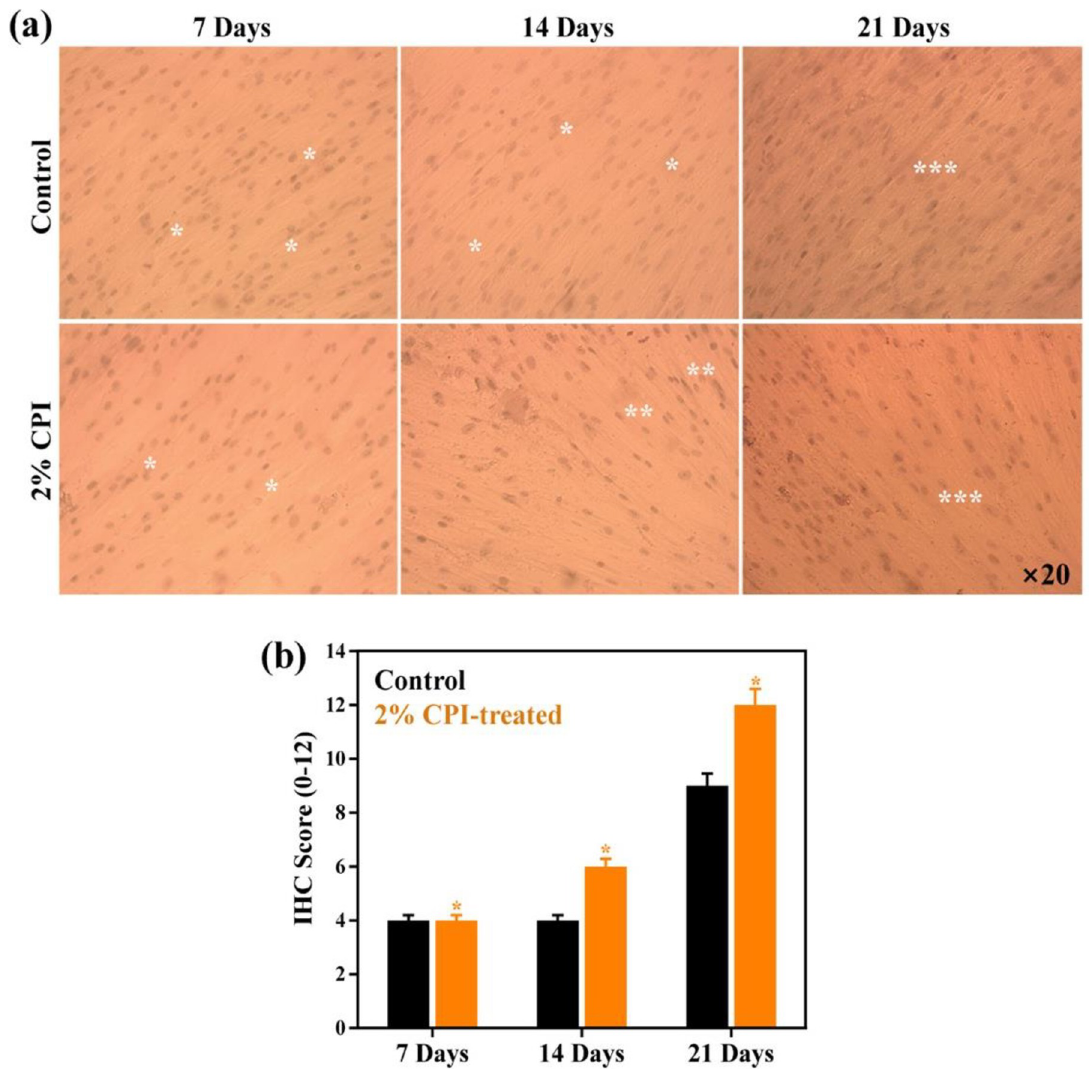
by hematoxylin counter staining of nucleus. Asterisks with ‘ � ’ indicates mild reaction, ‘ �� ’ indicates moderate reaction, and ‘ ��� ’ indicates intense reaction, (b) their corresponding IHC scores. Statistical significance at � p <